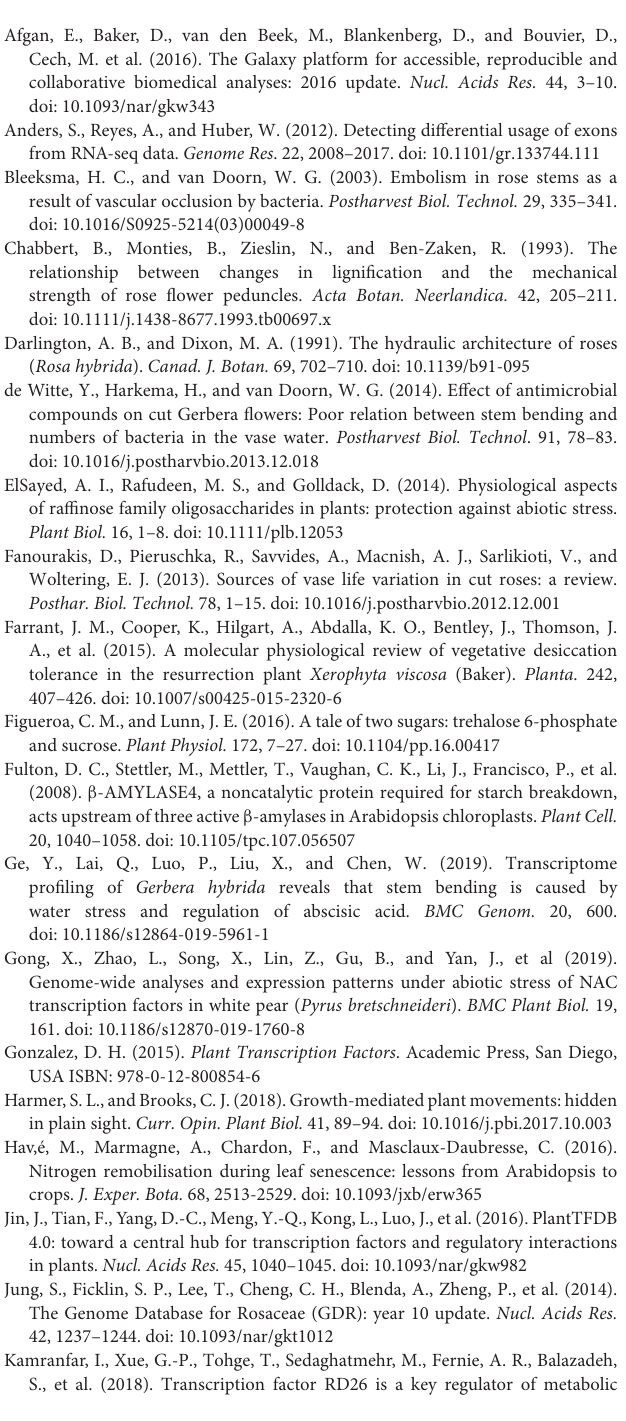
Supplementary Figure 5 | Heatmap of differentially expressed transcription factor families. Supplementary Figure 6 | Changes in expression of genes in the starch and sucrose metabolism